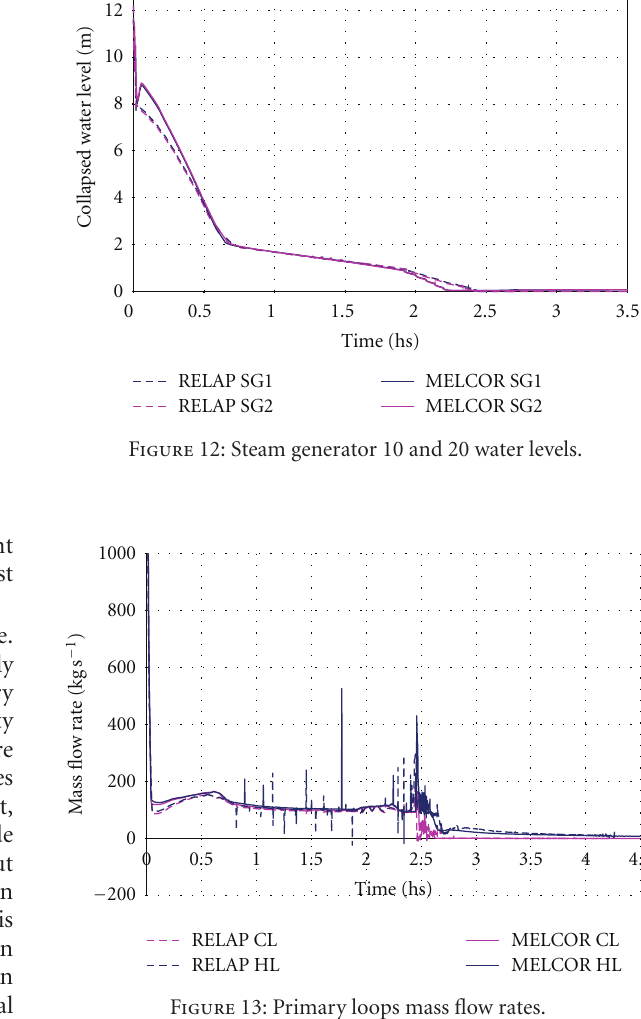
Figure 13: Primary loops mass flow rates.